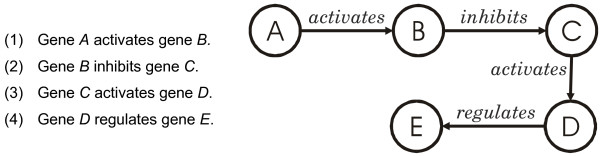
Example of transitive dependencies.